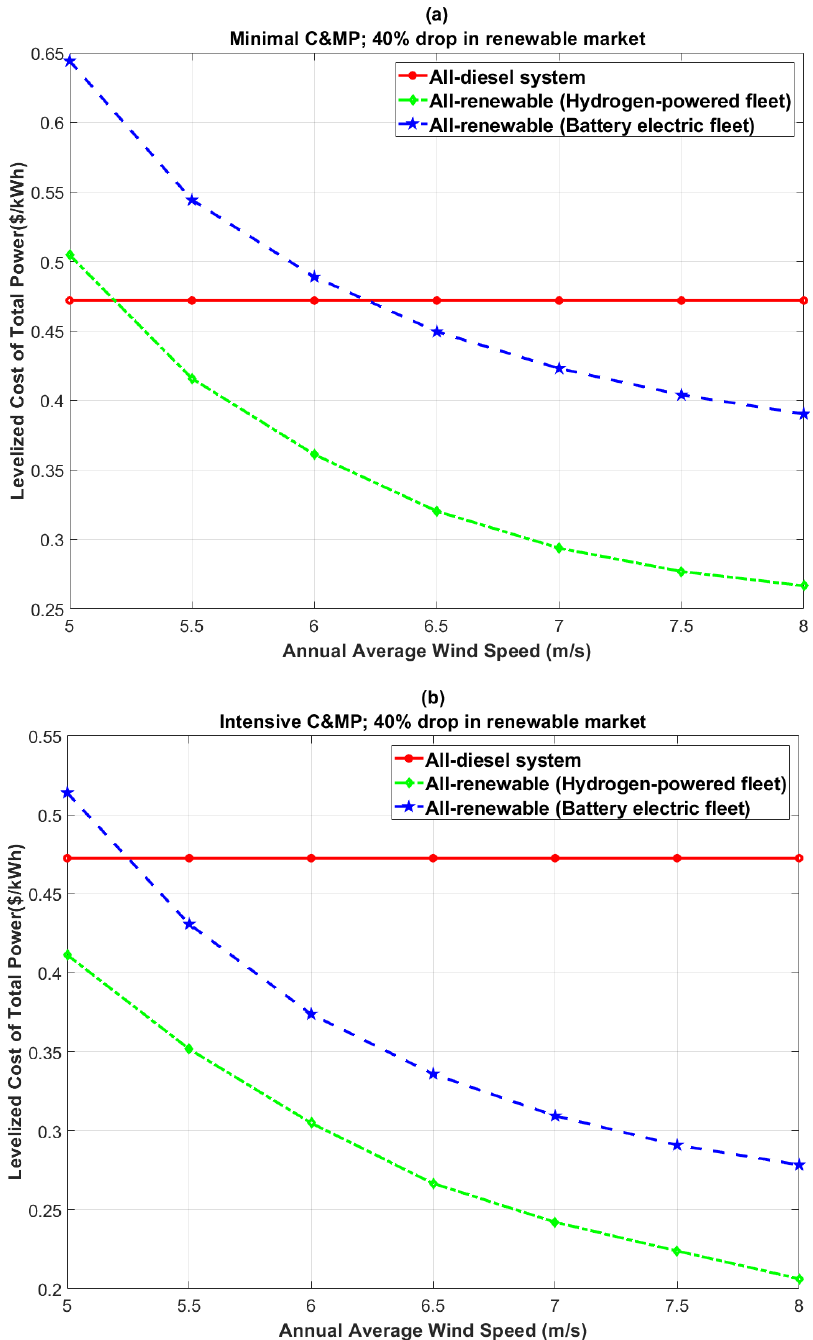
Figure 13. Wind speed impact on all-renewable system (Battery and FC storage config.) with 40% drop in renewable market: ( a ) surface mine with minimal C&MP; ( b ) surface mine with intensive C&MP.